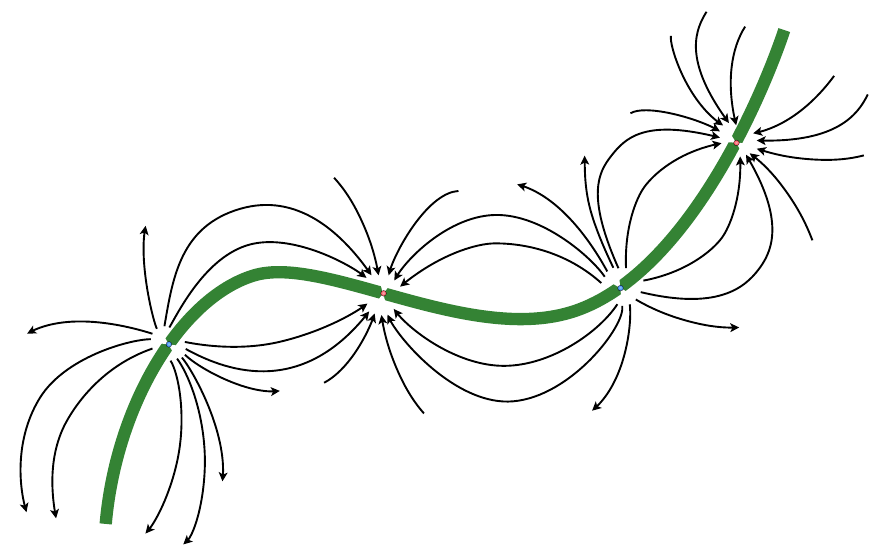
Figure 5 . A schematic picture of the magnetic necklace. The dark magnetic flux is trapped inside the necklace (the green line). In the presence of the kinetic mixing, the QED magnetic flux (the black lines) leaks out from the positions of the